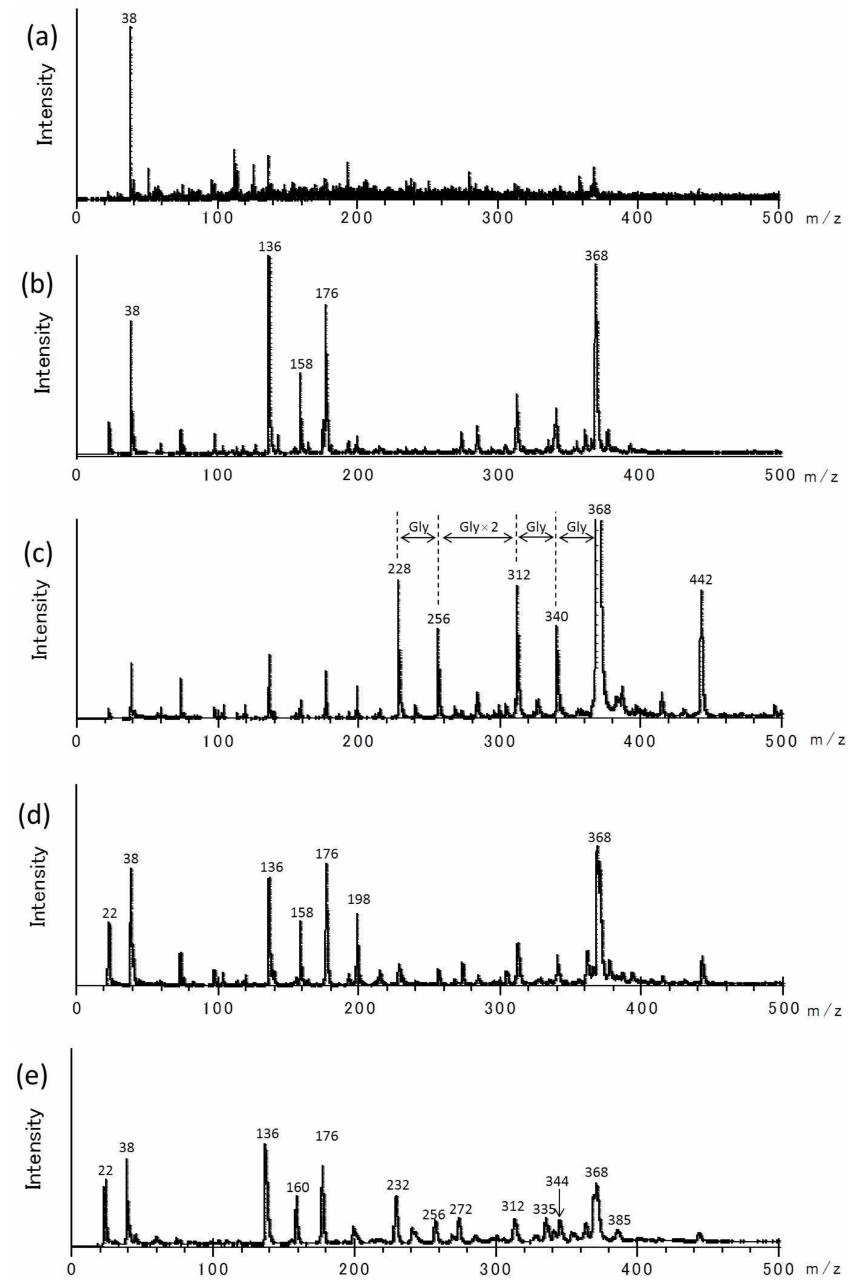
Figure 5. Mass spectra of ( a ) raw material and products after ( b ) 500, ( c ) 1000, ( d ) 3000, and ( e ) 5000 discharge plasma pulses at 18.6